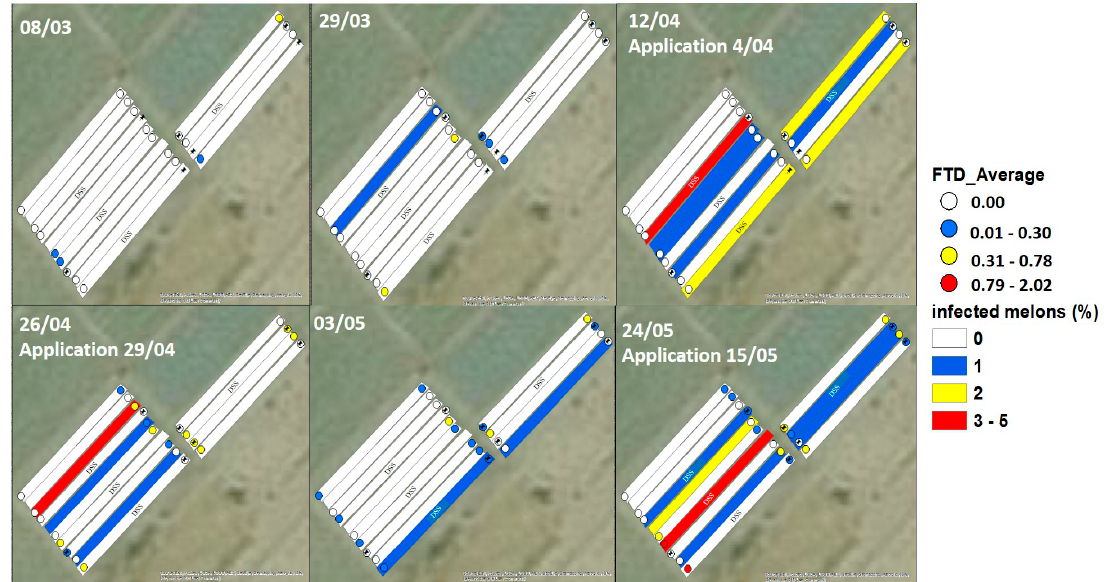
Figure 9. GIS-images of the average Ethiopian fruit fly trapping level by yellow sticky boards and RETIC traps (see Figure 5) in the southern melon growing areas of Ein Yahav, throughout spring of 2015 (several dates), and the percent of fruit infestation in the control (calendar-spraying management) and DSS-managed melon greenhouse plastic tunnels. Dates of calendar-spraying are noted within the figures.